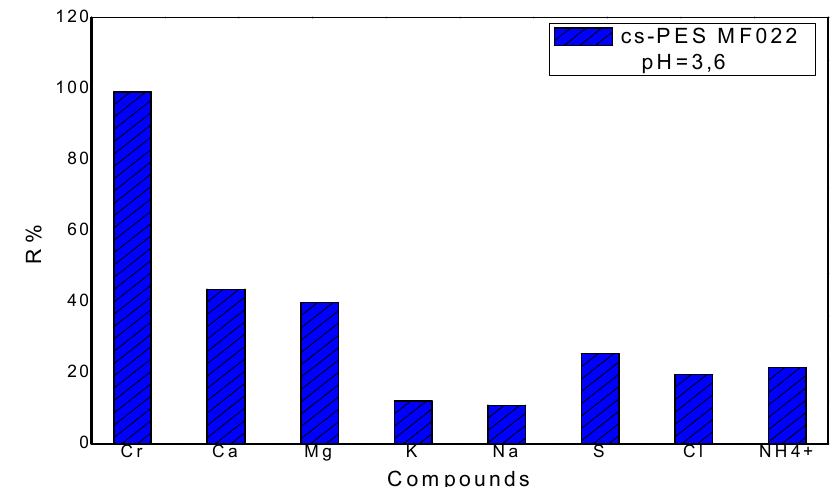
Figure 11. Rejection of the analysed compounds during filtration of synthetic tannery wastewaters at pH 3.6, using the chitosan modified membrane (cs ‐ PES MF 022).